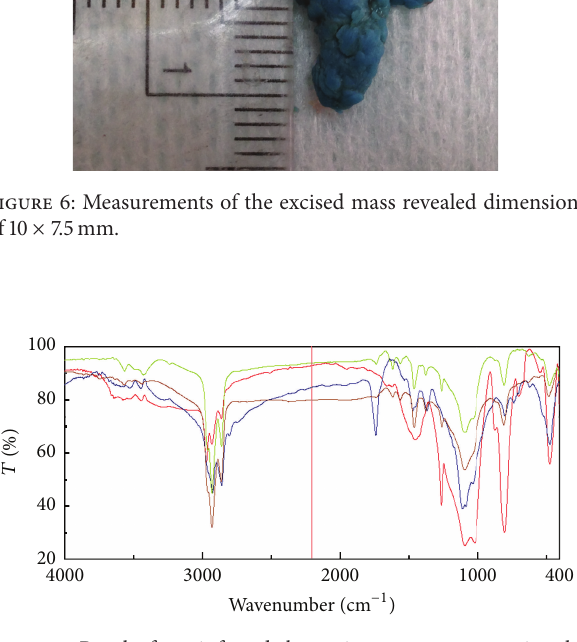
Figure 7: Results from infrared absorption spectroscopy, using the Fourier transform infrared (FTIR)